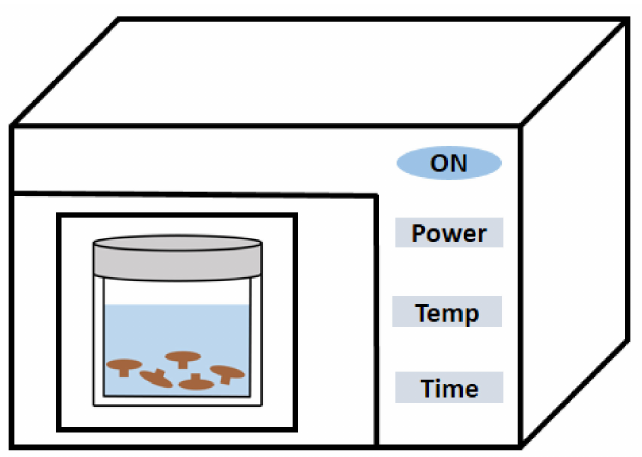
Figure 3. EFP extraction by